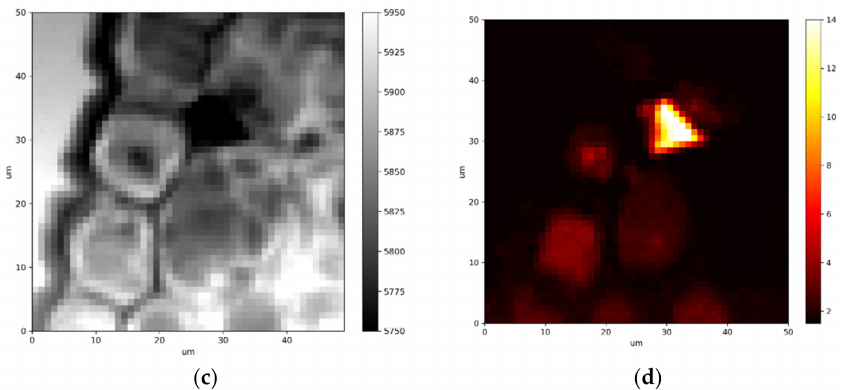
Figure 1. Localization of Si in leaves ( a ) an X-ray absorption image of common reed ( Phragmites australis ) leaf cross-section recorded at TwinMic beamline of synchrotron Elettra depicting X-ray dense regions (black) corresponding to biomineralized leaf areas. ( b ) An X-ray fluorescence image of Si distribution (colour bar in wt%) of common reed ( Phragmites australis ) leaf cross-section recorded at TwinMic beamline of synchrotron Elettra depicting Si accumulation in leaf epidermal region. Data are taken from [19]. ( c ) An X-ray absorption image of tea plant ( Camellia sinensis ) leaf cross- section recorded at TwinMic beamline of synchrotron Elettra depicting X-ray dense regions (black) corresponding to biomineralized leaf areas. ( d ) An Si-rich phytolith in leaf mesophyll of a tea plant (colour bar in wt%). The epidermis in incrusted with Ca (not